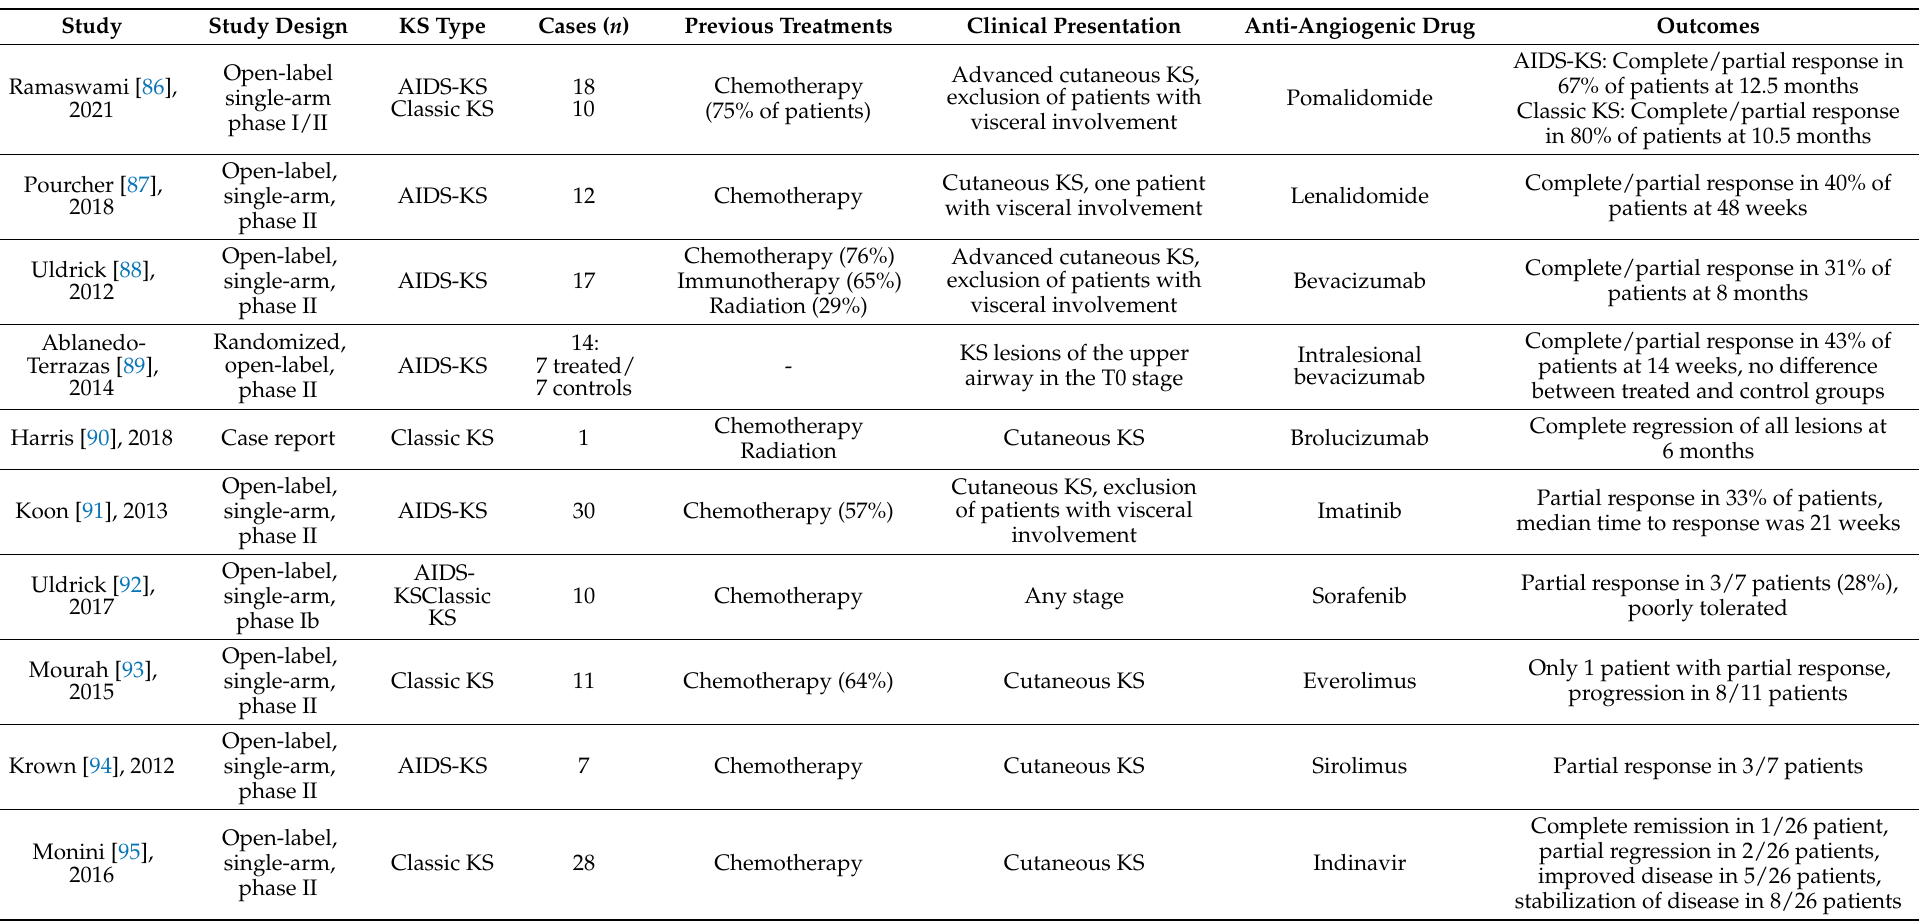
Table 1. Clinical cases and series evaluating anti-angiogenic drugs for classic and AIDS-associated